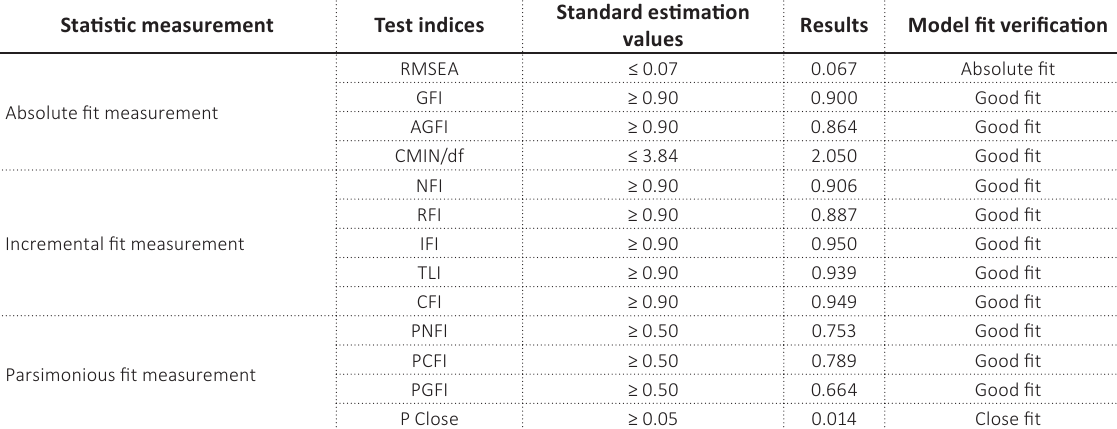
Table 3. The goodness of fit